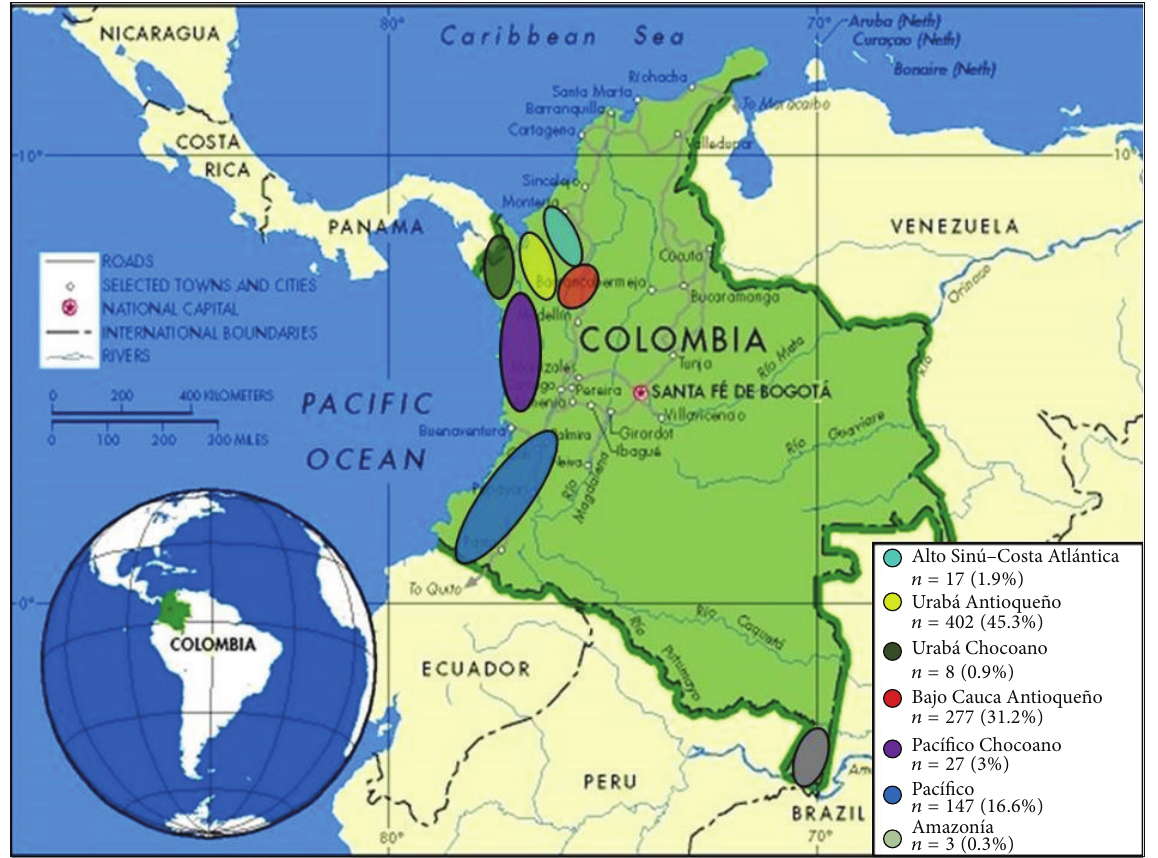
Figure1:Geographicallocationofpatients’residencebyColombianmalarialendemicregions.ObtainedandmodifiedfromtheCartographic Design Unit of the World Bank, 2000.